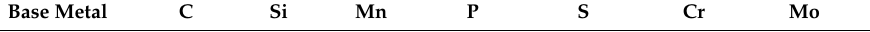
Table 1. The chemical composition of the TRIP800 steel (% weight).